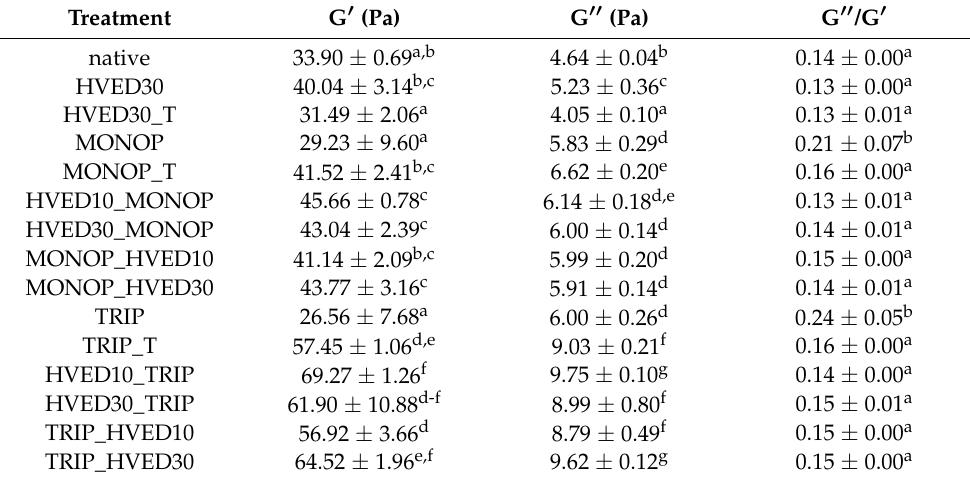
Table 4. Viscoelastic properties (storage modulus (G (cid:48) ), loss modulus (G (cid:48)(cid:48) ) and loss tangent (counted by frequency 1Hz) (G (cid:48)(cid:48) /G (cid:48) )) of native and modified maize starches (HVED10 = 10 min treatment with HVED; HVED30 = 30 min treatment with HVED; MONOP = Na 2 HPO 4 ; TRIP = Na 5 P 3 O 10 ; T = thermal